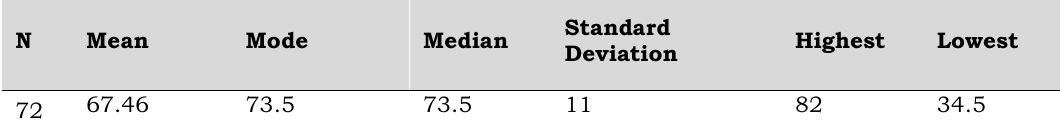
Table 4. The scores of writing of the low creative